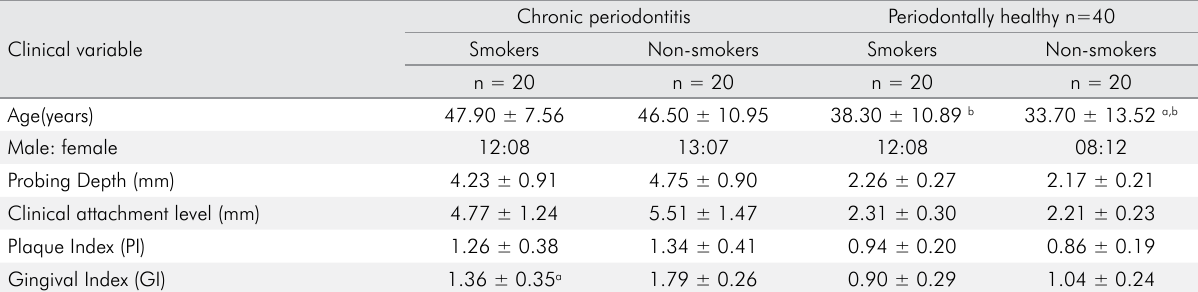
Table 1. Clinical measurements (mean±standart deviations) of smoker and non-smoker chronic periodontitis and periodontally healthy